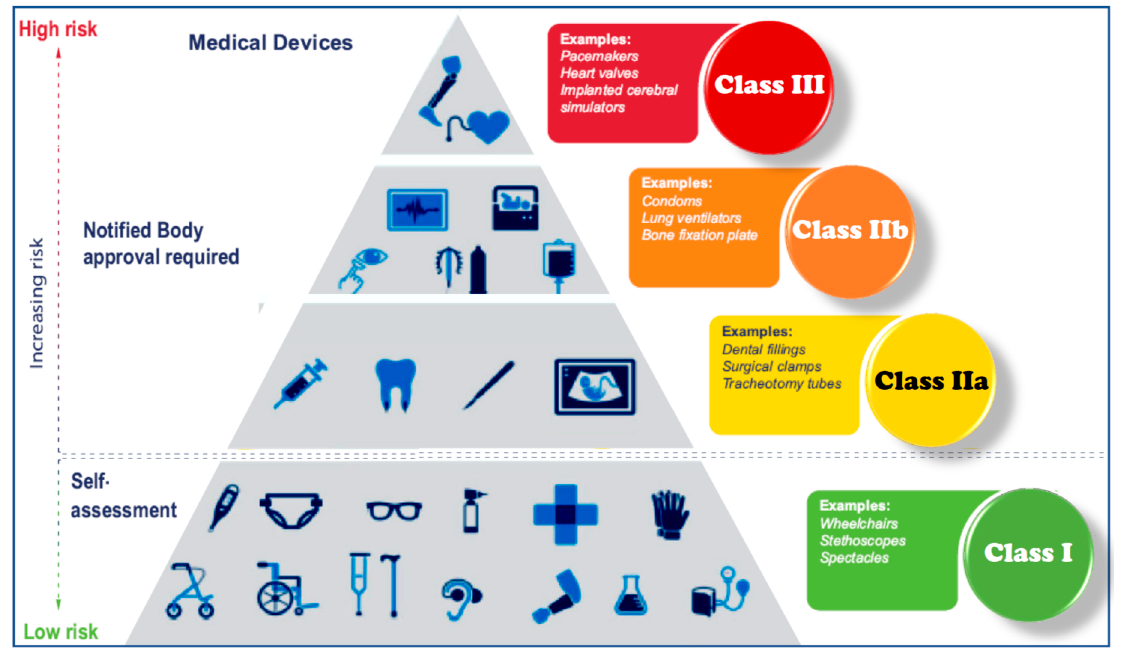
Figure 15. Scheme of the general classification of medical devices depending on the application risk.